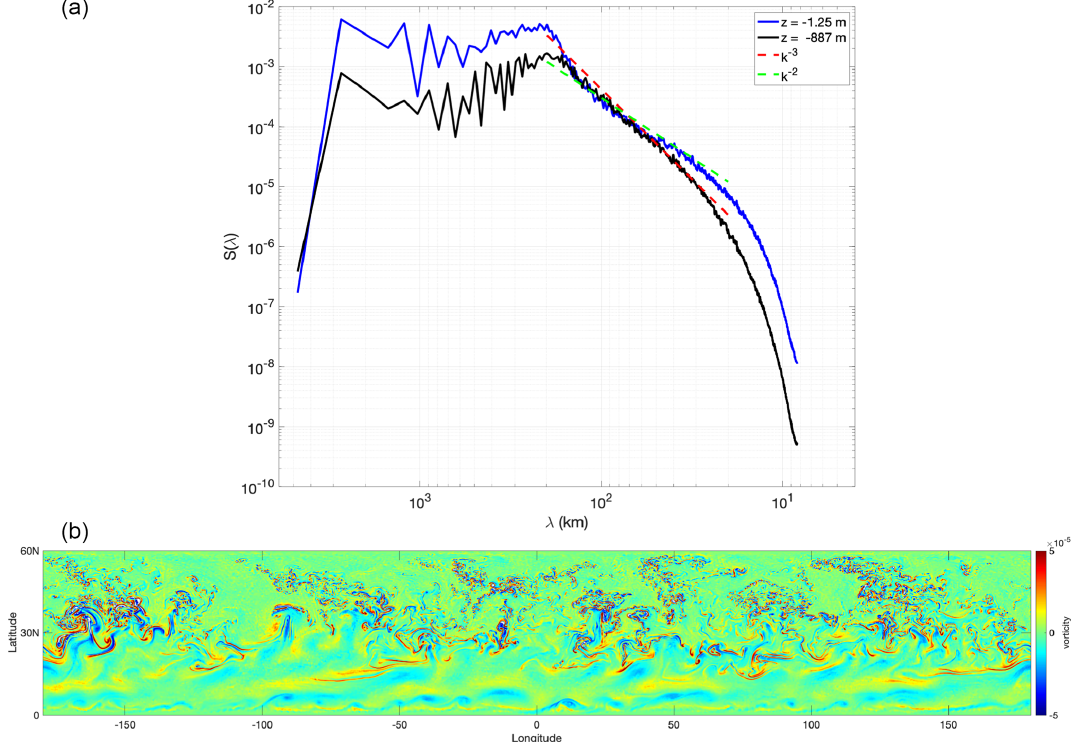
Figure 10. (a) Spherical harmonics energy spectrum for the baroclinic jet test case at 600d with tolerance ε = 0 . 02 near the surface at depth z = − 1 . 25m and at a depth of z = − 887m. Near the surface the power law is close to k − 2 , while in the interior it is slightly shallower than k − 3 . (b) Latitude–longitude projection of the associated vorticity field at z = − 1 . 25m in the zonal channel with zonal length 6283km (at the Equator) and meridional width